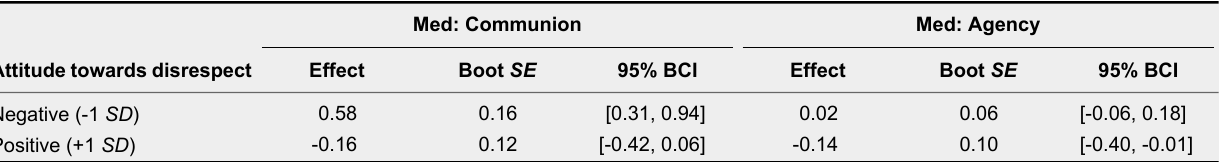
Conditional Indirect Effect of Disrespectful (Steinbrück) vs. Respectful (Merkel) Candidate Behavior a on Voting Decision Dependent on Attitude Towards Disrespect in Study 2